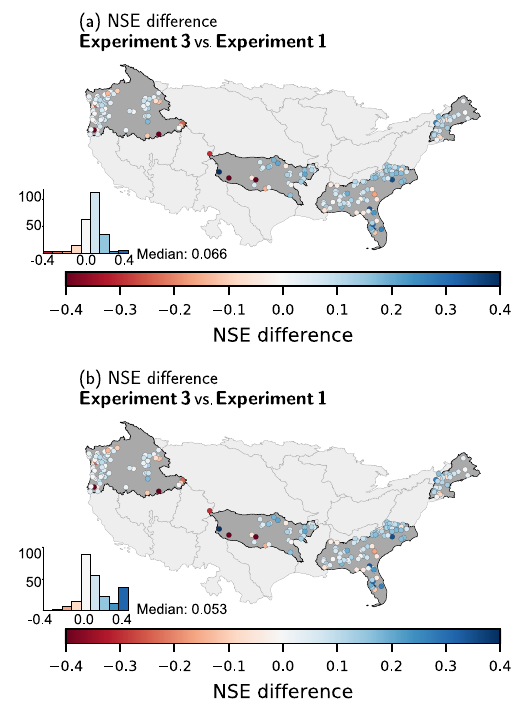
Figure 13. Panel (a) shows the difference of the NSE in the vali- dation period of Experiment 3 compared to the models of Experi- ment 1 and panel (b) in comparison to the models of Experiment 2. Blue colours ( > 0) indicate in both cases that the fine-tuned models of Experiment 3 perform better and red colours ( < 0) the opposite. The NSE differences are capped at [ − 0 . 4, 0.4] for better visualiza-